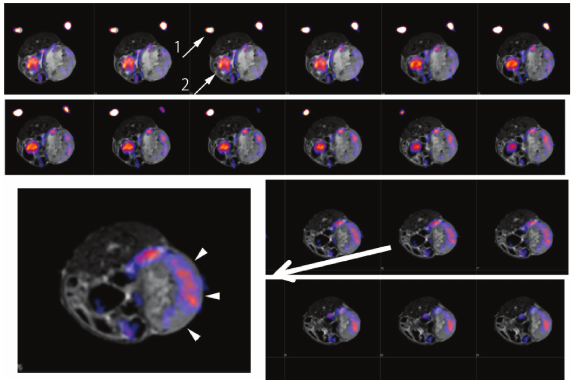
Figure 4: In vivo fusion imaging of intratumoral distribution of 125 I-POS and MR images. A representative image is enlarged. Arrows 1: markers, arrows 2: urinary bladder, and arrowheads: the